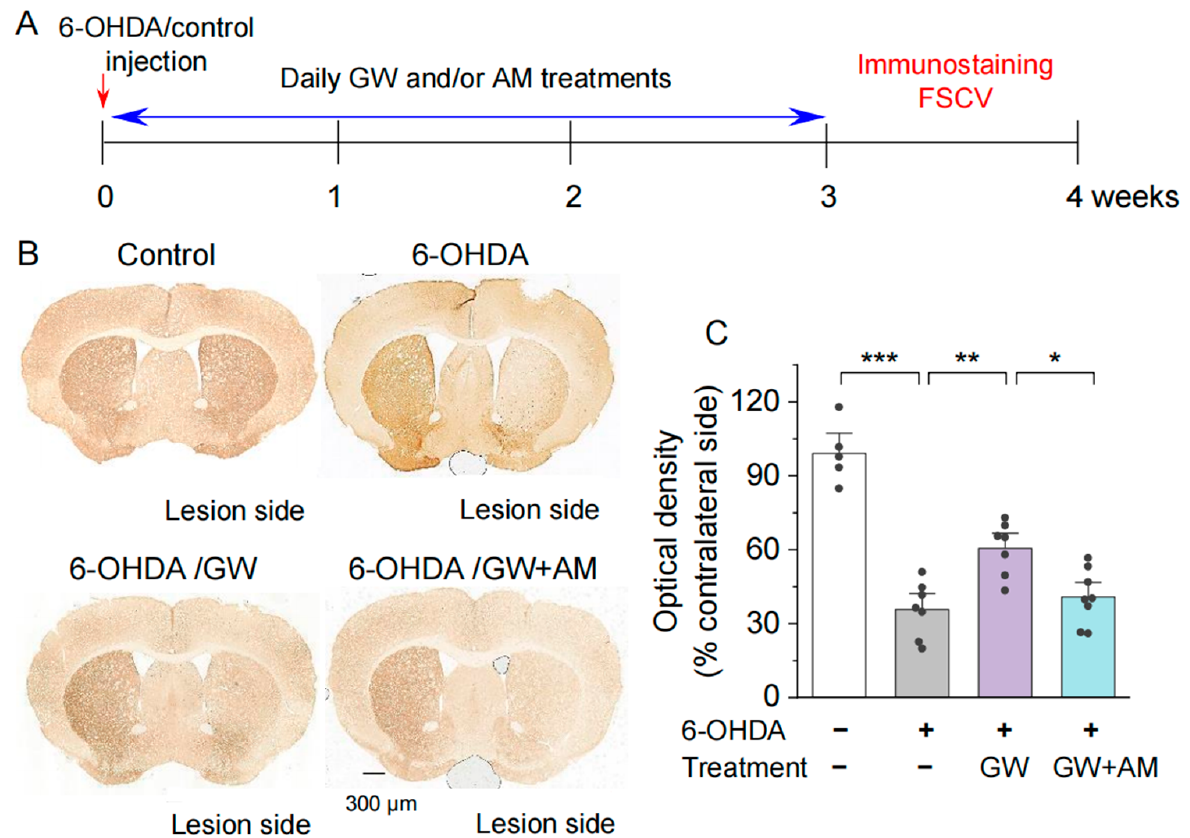
Figure 2. GW842166x (GW) was neuroprotective against 6-OHDA-induced loss of dopaminergic axonal terminals in the striatum. ( A ) Timeline of intra-striatal injection, drug treatments, and histology or FSCV recording. ( B ) DAB staining for TH+ axonal terminals in the striatum of mice that re- ceived intra-striatal injection of 6-OHDA or control solution and chronic GW or GW + AM630 (AM) treatments. ( C ) Summarized data showing that the optical density of TH + axonal terminals in the striatum was significantly decreased in the 6-OHDA group relative to control (*** p < 0.001; n = 5–7 slices from 3–4 mice). Chronic GW treatments reduced 6-OHDA-induced loss of dopaminergic ter- minals (** p = 0.002; n = 7–7 slices from 4–4 mice), and this effect was blocked by AM co-treatment (* p = 0.013; n = 7–8 slices from 4–4 mice).